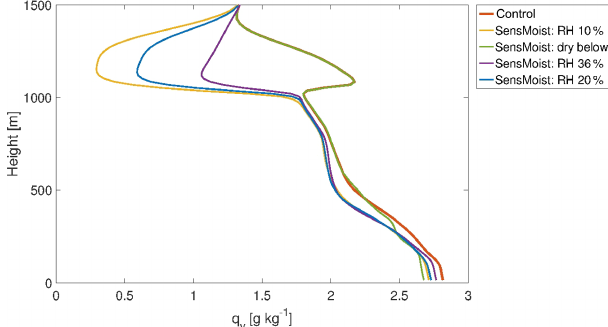
Figure 8. Mean profiles of the water vapor (QV) are shown after 5h of simulation for the control simulation (red) and the SensMoist simulations (RH 10%: yellow; dry below: green; RH 36%: purple; and RH 20%: blue). Figure 9. Mean values of LWC (blue) and IWC (red) for the Sens- Moist simulation with the RH of 10% above the cloud